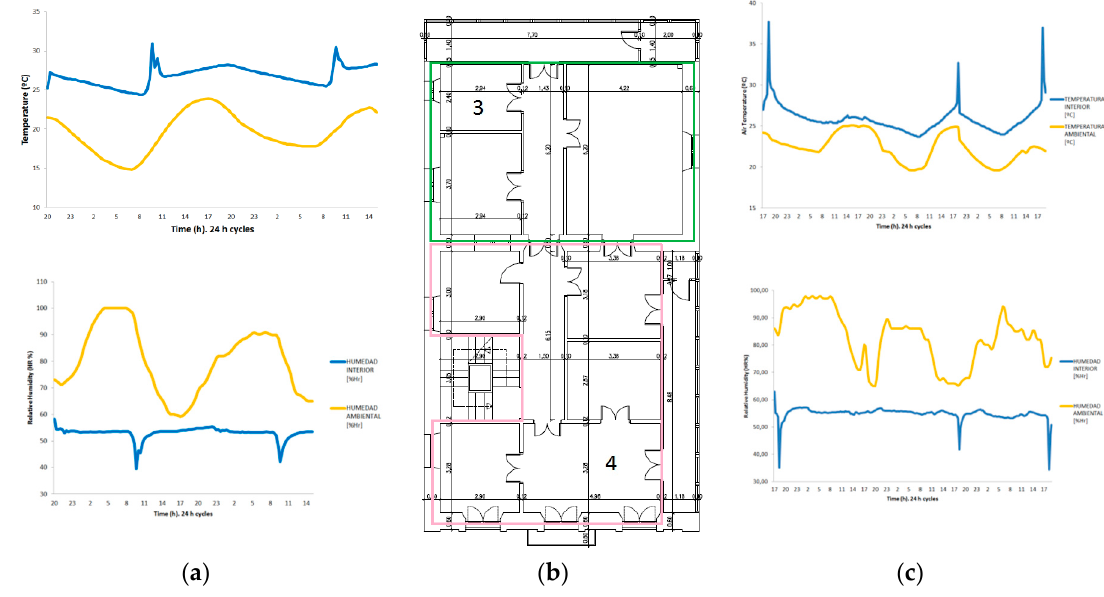
Figure 4. ( b ) Sections 3 and 4 , on the first floor. T Indoor /RH Indoor (blue line) and T Outdoor /RH Outdoor (yellow line) evolution: ( a ) from 21 to 23 August 2016, at Section 3 ( c ) from 18 to 21 August 2016, at Section 4